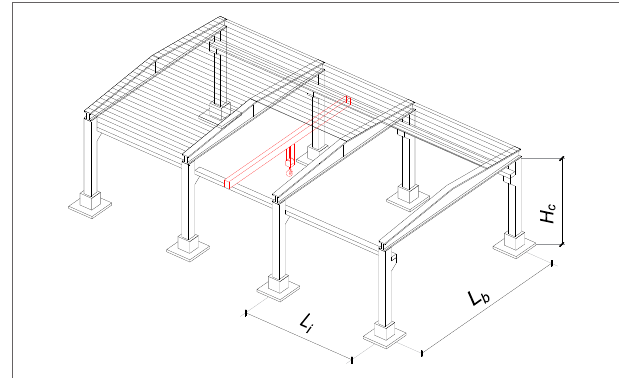
FigUre 6 | Considered structural typology.